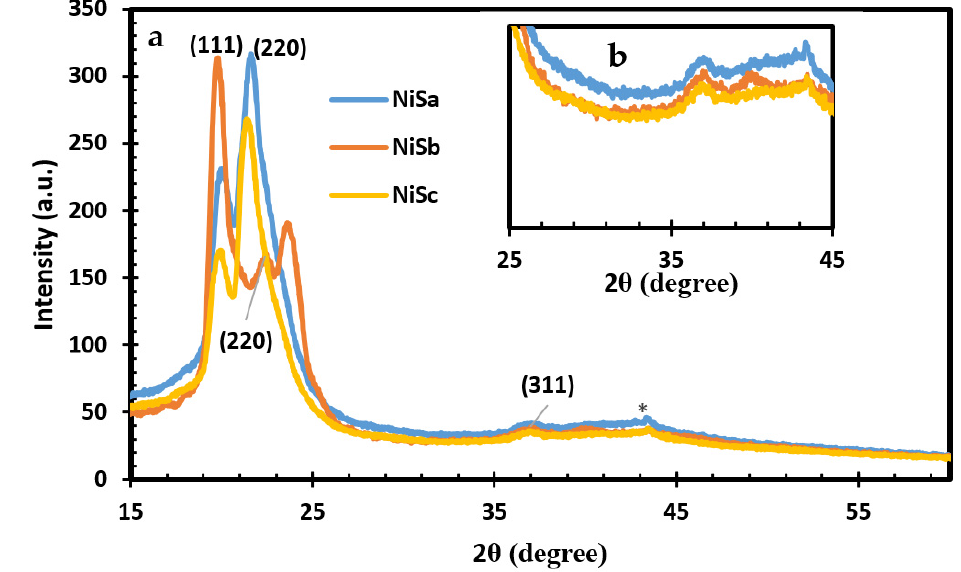
Figure 2. XRD spectra for NiSa, NiSb, and NiSc as ( a ) and inset Figure as ( b ) nanoparticles.